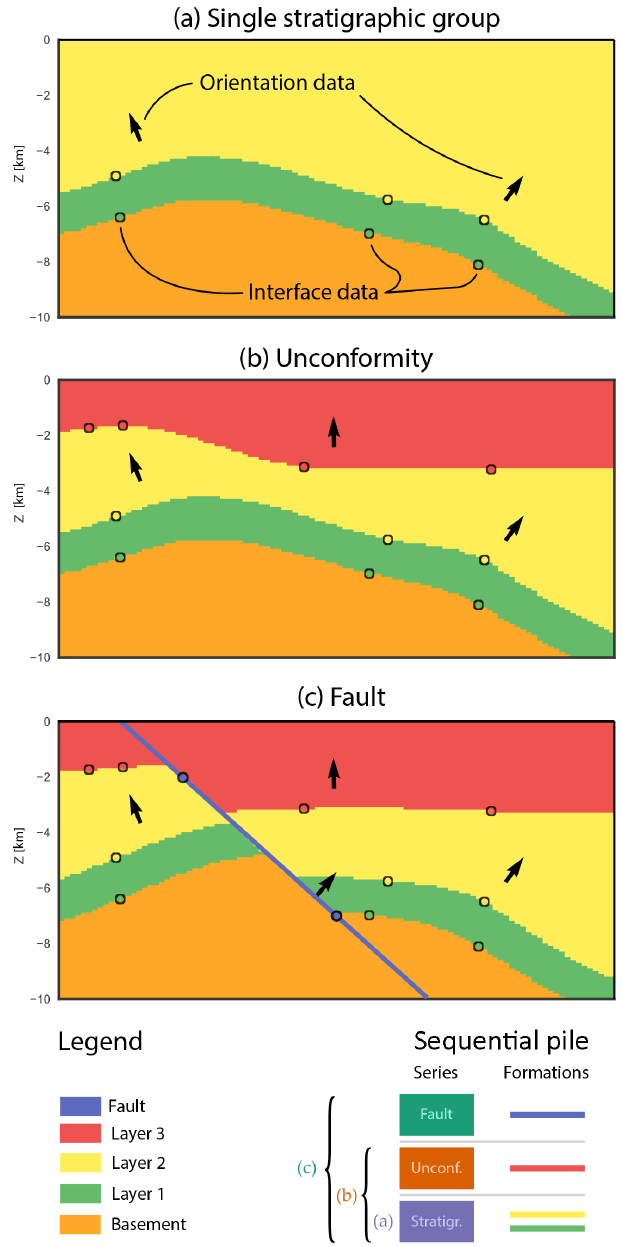
Figure 3. Example of different lithological units and their relation to scalar fields; (a) Simple stratigraphic sequence generated from a scalar field as product of the interpolation of interface points and orientation gradients; (b) Addition of an unconformity horizon from which the unconformity layer behaves independently from the older layers by overlying a second scalar field; (c) Combination of uncon- formity and faulting using three scalar fields.